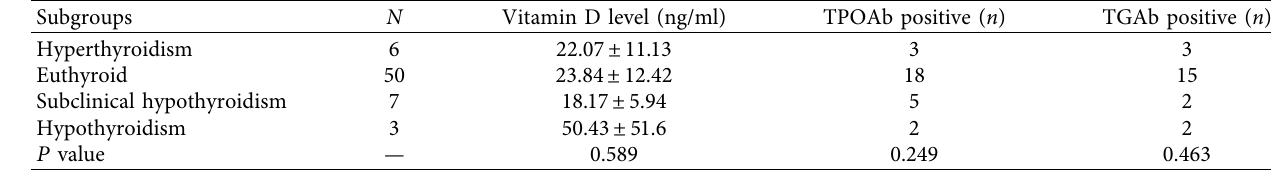
Table 2: Results of thyroid tests and vitamin D level in each group.